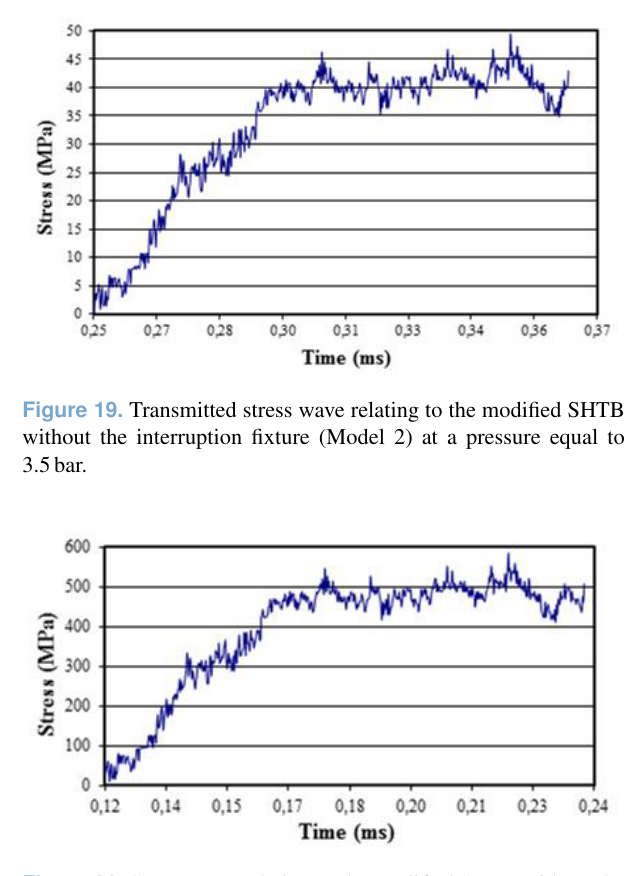
Figure 20. Stress wave relating to the modified SHTB without the interruption device (Model 2) at a pressure equal to 3.5bar.